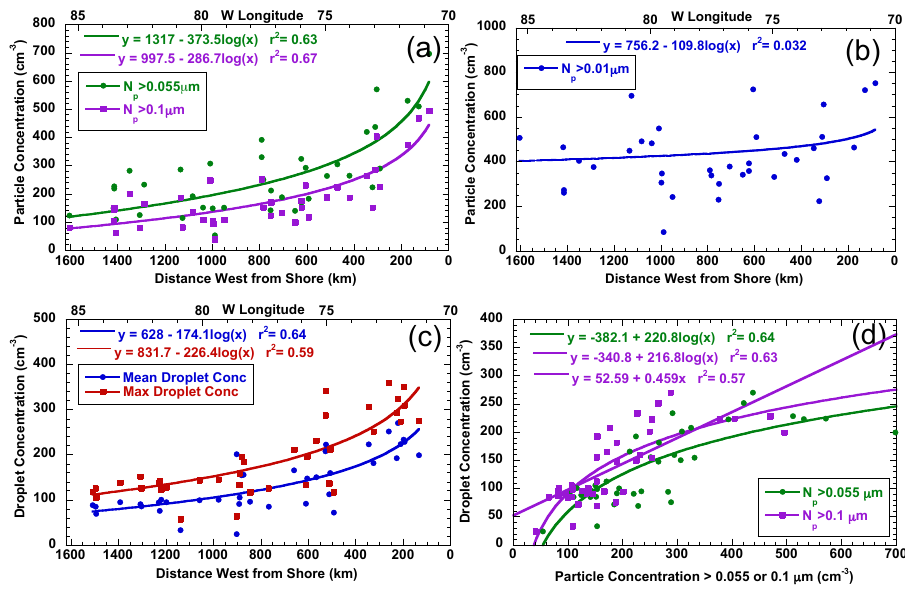
Fig. 1. (a) Mean below-cloud aerosol number concentration vs. distance west from shore along 20 ◦ S latitude line for legs on eight differ- ent VOCALS C-130 flights. Top axis shows longitude. Green represents data from the UHSAS ( > 0.055µm diameter) and purple from the PCASP ( > 0.10µm). Median standard deviation along the flight legs was 29 for the UHSAS concentration, and its estimated uncertainty is 8%. Median standard deviation along the flight legs was 18 for the PCASP concentration. Its estimated uncertainty from flow rate uncertain- ties was 10% for all but flights 3 and 4, when it was corrected based upon the corresponding UHSAS concentration due to a possible leak. For those two flights we estimate 20% uncertainty. (b) Below-cloud number concentration from the CPC ( > 0.01 µm). Median standard deviation along the flight legs was 30 for the CPC concentration, and its estimated uncertainty is < 6% (Twohy, 1991). (c) Cloud droplet number concentration from the CDP as a function of distance from shore. Median standard deviation along the flight legs was 28 for the CDP concentration, and its uncertainty is estimated to be a maximum of about 25% (low bias) at a droplet concentration of 300cm − 3 (Lance et al., 2010). (d) Particle concentration in two different size ranges vs. droplet